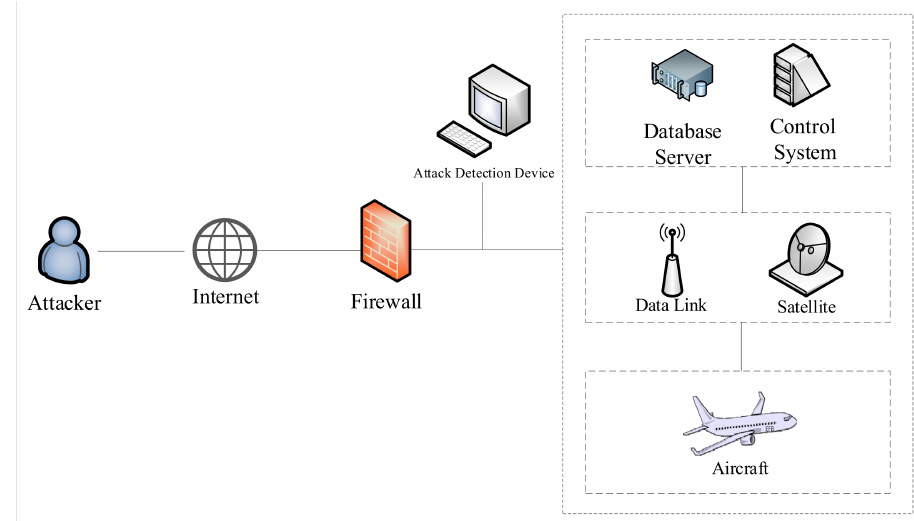
Figure 5. Experimental Topology.